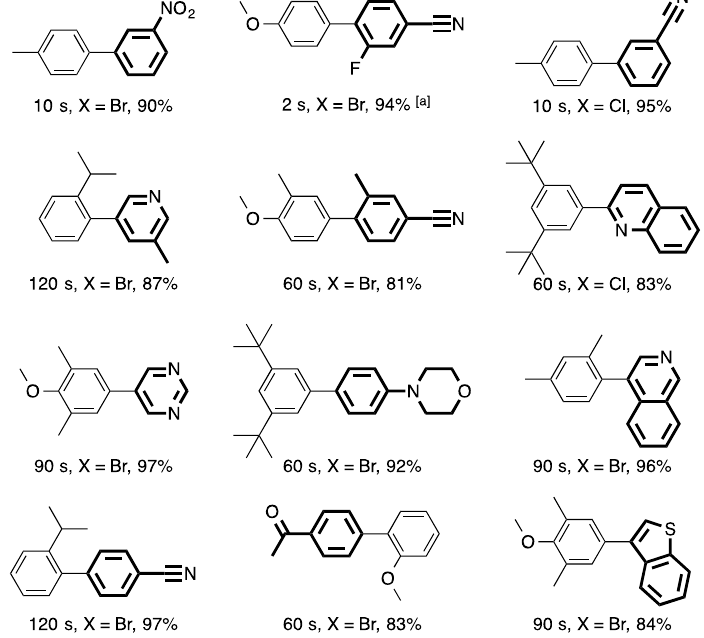
Figure 1. Substrate scope of continuous flow lithiation/borylation/Suzuki–Miyaura cross-coupling sequence starting from aryl bromides.